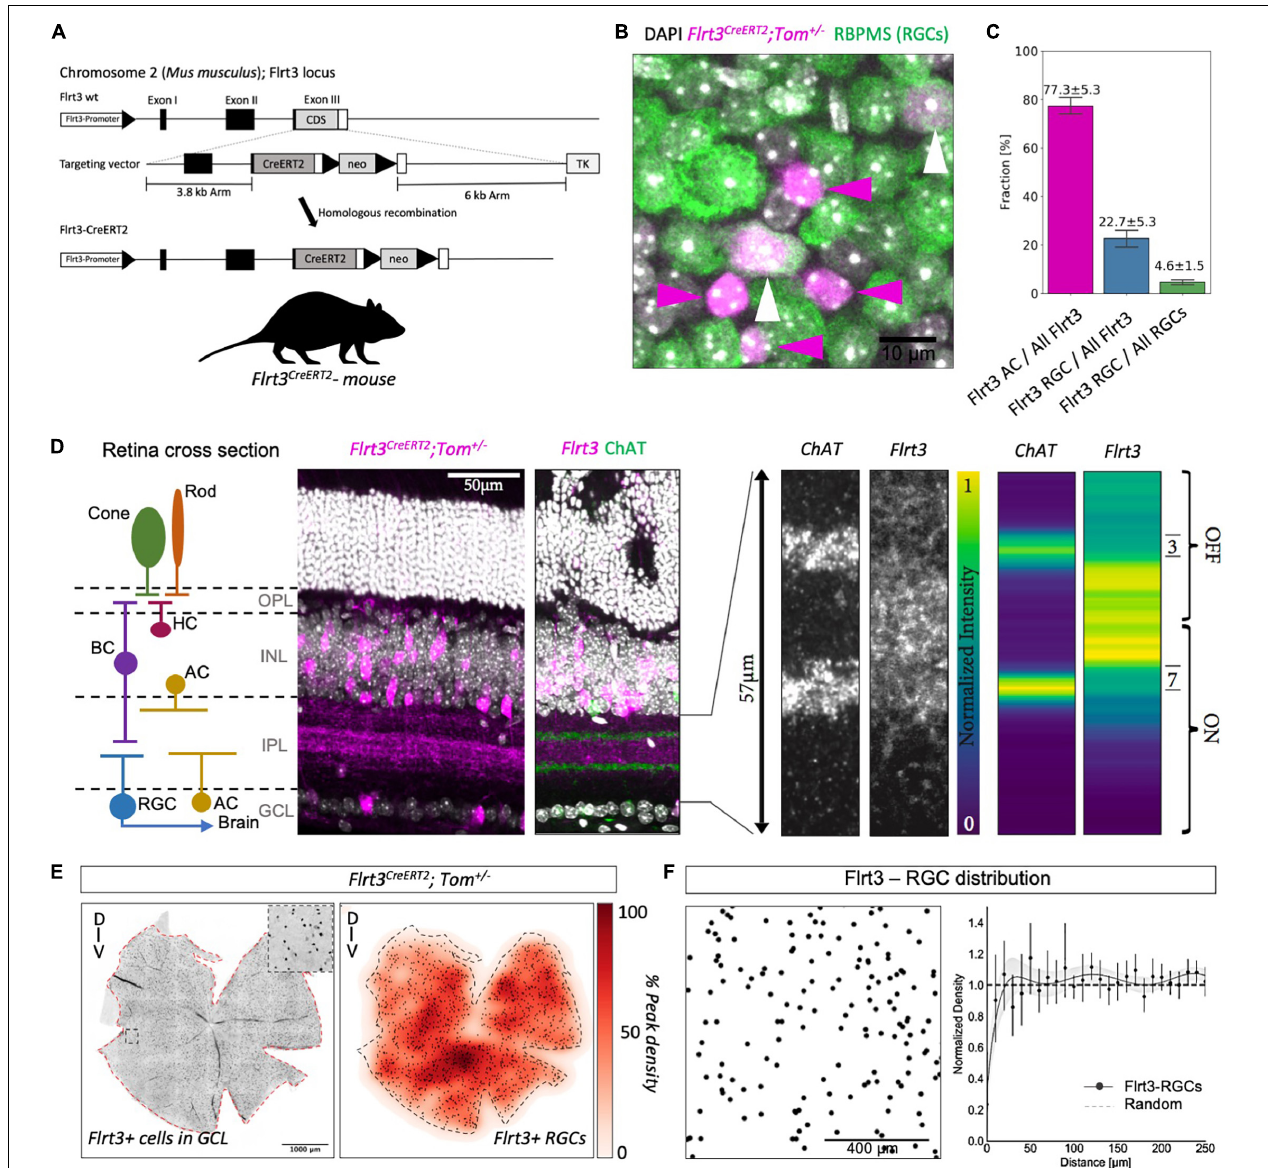
FIGURE 1 | Flrt3 neuronal distribution in the mouse retina. (A) Scheme of the Flrt3-CreERT2 mouse. (B) Immunostaining showing Flrt3+ cells in magenta (tomato), RGCs in green (RBPMS), and the nucleus in white (DAPI). The white arrows indicate FLRT3-RGCs and the magenta arrows FLRT3-amacrine cells. (C) Plot showing the fractions of Flrt3-amacrine (AC) and FLRT3-RGCs in the Flrt3-CreERT2 mouse. Two complete retinas were counted and another three representative regions of interest (ROIs) of another two retinas were included in the quantification. (D) Retina sections of Flrt3-CreERT2;Tom ± mouse showing Flrt3 cells in purple and ChAT bands in green. The left panel shows the anatomical structure and cell types of a typical retinal section. The right panel shows a zoom of the IPL region and normalized intensity of ChAT and Flrt3 signals. AC, amacrine cells; BC, bipolar cells; HC, horizontal cells; RGC, retinal ganglion cell; OPL, outer plexiform layer; INL, inner nuclear layer; IPL, inner plexiform layer; GCL, ganglion cell layer. (E) Representative retina density profile (%) of Flrt3-CreERT2;Tom ± mice. The left panel shows the distribution of Flrt3+ cells in the ganglion cell layer. The right panel shows the density of Flrt3+ RGCs identified from the left panel. N = 2 retinas from 2 mice (F) Random distribution of Flrt3-RGCs. Left panel: Flrt3-RGC distribution in a ROI of a retina region. Each dot represents a Flrt3+ RGC. Right panel: Density recovery profile of Flrt3+ RGC showing a random distribution. Graph shows Mean value ± SEM. Line represents a 7th order fit of the mean values. Shaded area is the 99% confidence interval. N = 4 retinas from 2